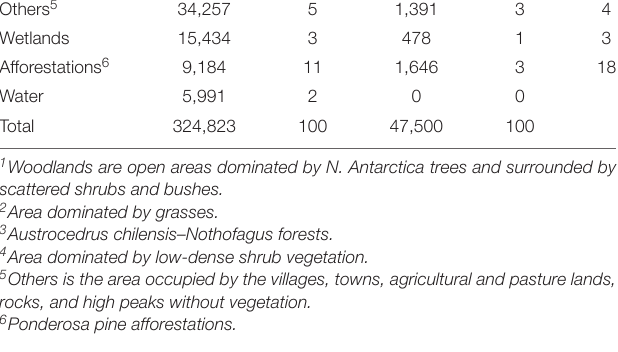
et al., 2018). The number of houses in our study area increased